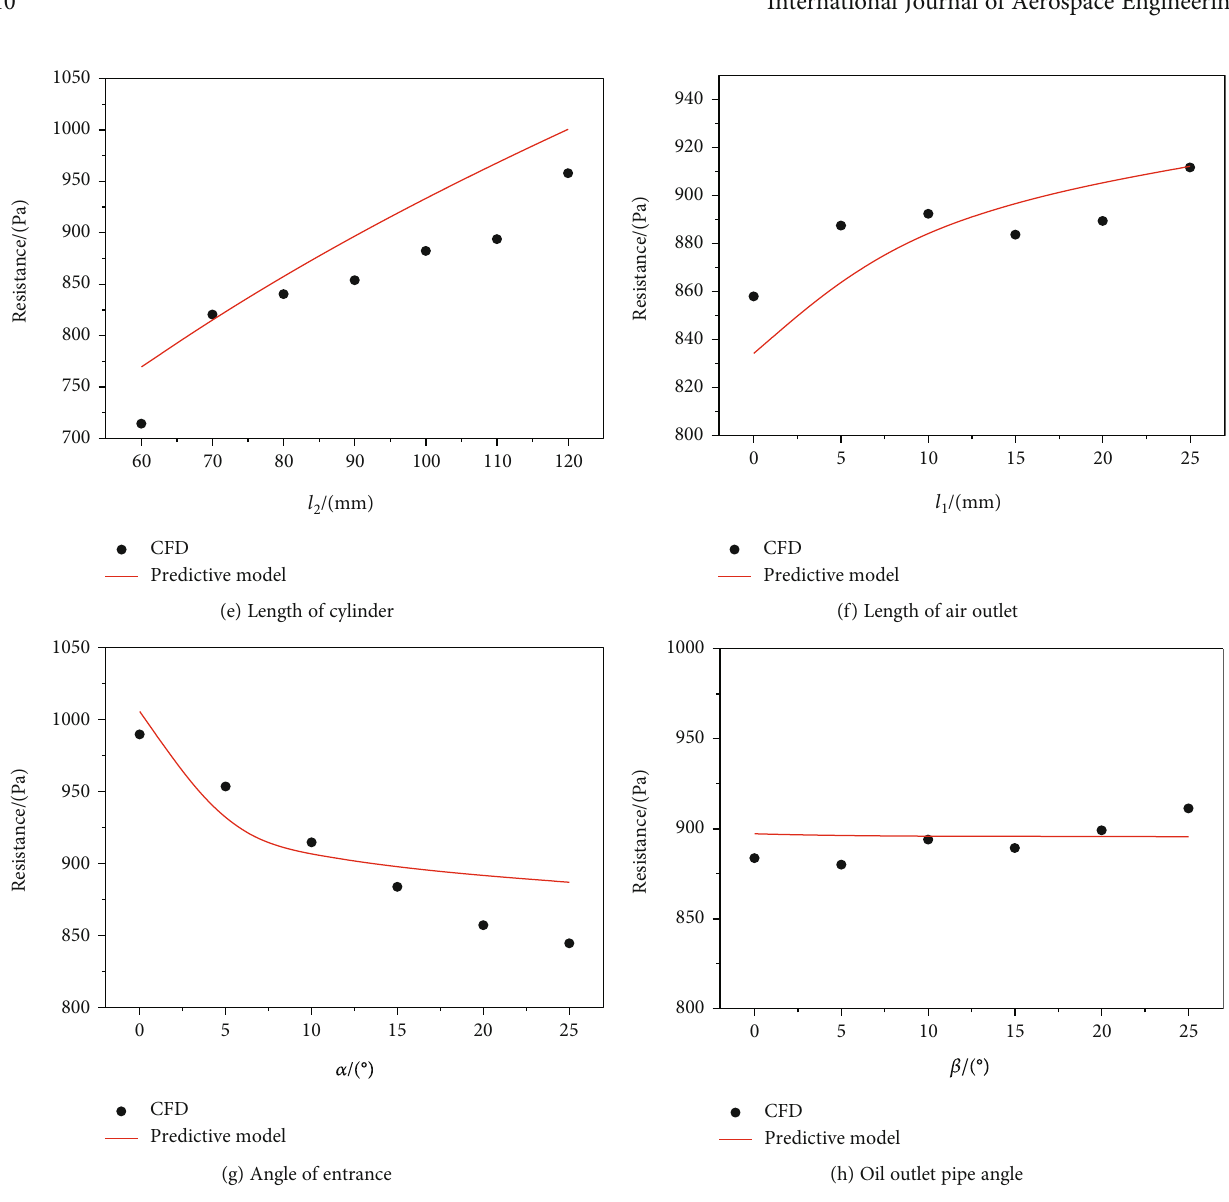
Figure 9: E ff ect of fl ow and structure parameters on separator